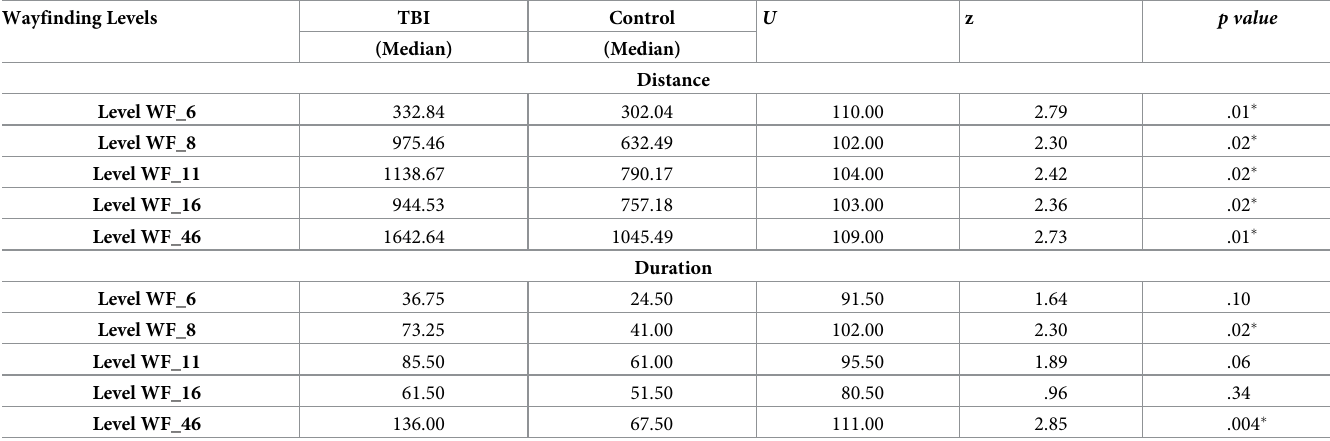
Distance measured by Euclidean distance travelled in pixels and duration measured in seconds. � p < 0.05.